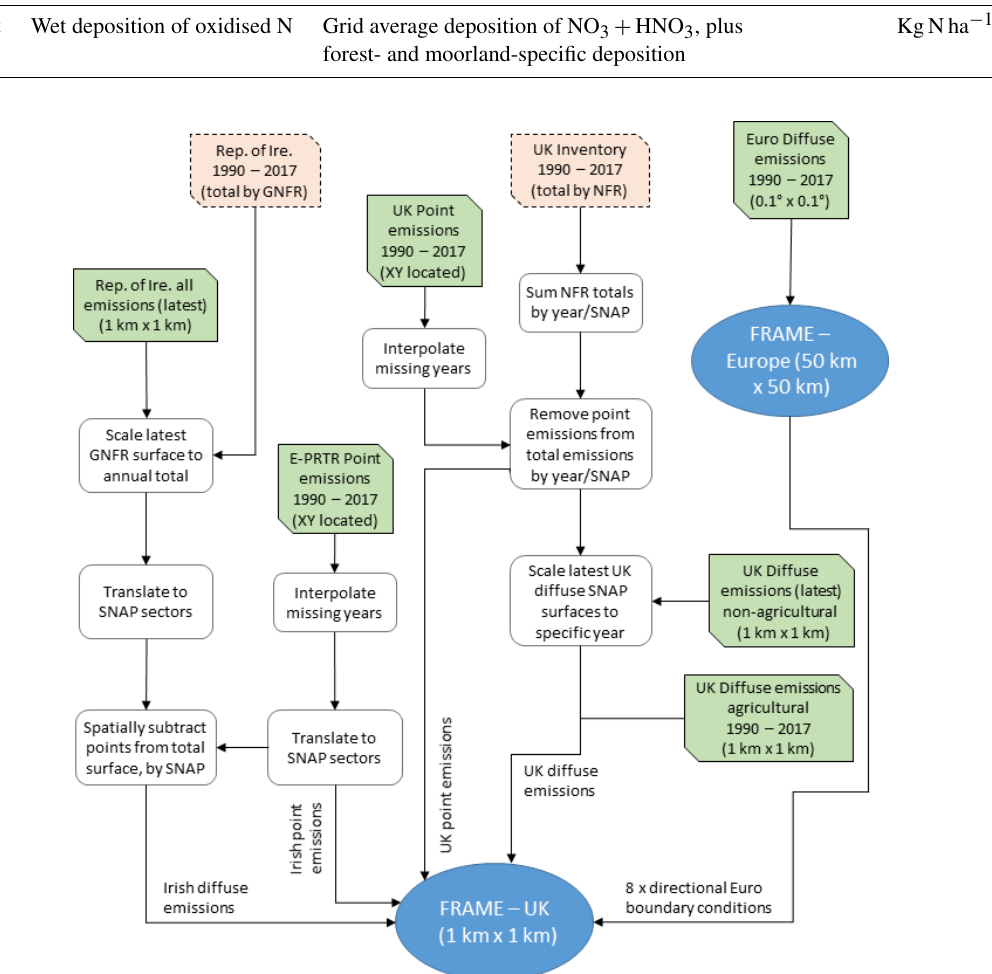
Figure 2. Visualised methodology of steps to create inputs for the Fine Resolution Multi-pollutant Exchange (FRAME) atmospheric chem- istry transport model: rectangle with corners missing (solid border) denotes spatial data, rectangle with corners missing (dashed border) denotes tabulated data, rectangle with rounded corners denotes process and oval denotes